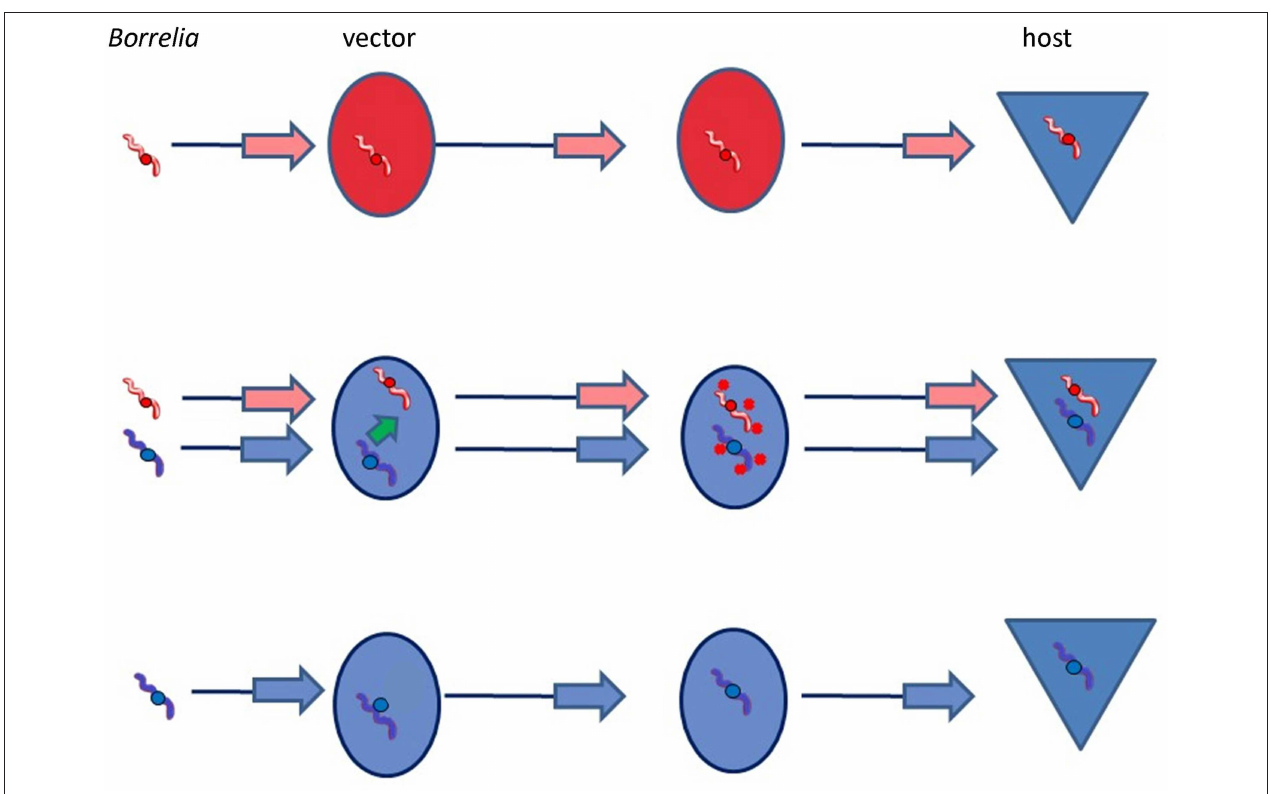
FIGURE 6 | Public goods vector adaptation hypothesis. In this scenario, two Borrelia species that are present in the same vector tick may both benefit from molecules that are secreted by the species that is adapted to this vector species. These molecules may protect both species against adverse conditions encountered during the transmission process in the vector. However, for adaptation to the new vector to be accomplished, appropriate genes permitting adaptation need ultimately to be